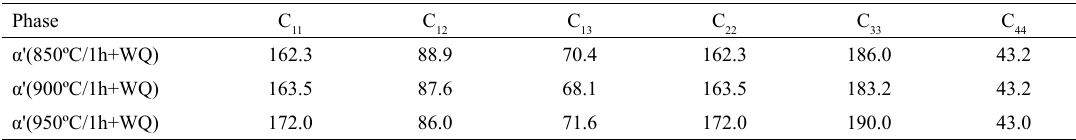
) of α' phase from ij